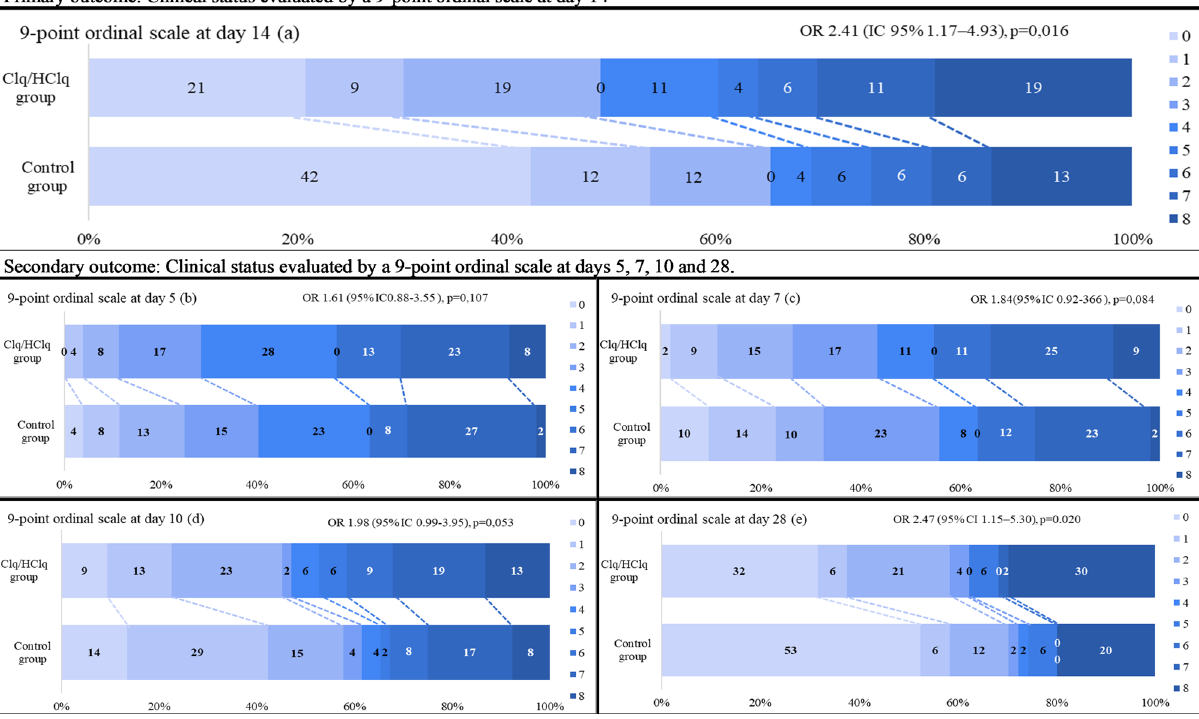
Figure 2. Primary and secondary outcomes in the mITT population from presentation to the evaluation of clinical status with a 9-point ordinal scale. (a) Clinical status evaluated by a 9-point ordinal scale at day 14. (b) Clinical status evaluated by a 9-point ordinal scale at day 5. (c) Clinical status evaluated by a 9-point ordinal scale at day 7. (d) Clinical status evaluated by a 9-point ordinal scale at day 10. (e) Clinical status evaluated by a 9-point ordinal scale at day 28; one patient in the control group did not have an ordinal scale score ascertained at day 28 because of loss to follow-up. The scores on the scale were defined as follows: (0) nonhospitalized and no clinical or virological evidence of infection; (1) nonhospitalized and no limitation on activities; (2) nonhospitalized, but with limitation on activities; (3) hospitalized, but not requiring supplemental oxygen; (4) hospitalized and on oxygen via mask or nasal prongs; (5) hospitalized, on noninvasive ventilation or high-flow oxygen or pressure support ventilation in weaning mode; (6) hospitalized, intubated and on MV; (7) hospitalized on MV and additional organ support (renal replacement therapy, vasoactive drugs or extracorporeal membrane oxygenation), and (8) dead. The percentages shown have been rounded to whole numbers. ORs (95% CIs) and p values were derived from ordinal logistic regression, assuming proportional ORs, adjusted for age and baseline severity (according to ventilatory support) for the mITT population. An OR > 1.00 represents a clinical worsening assessed with the ordinal scale in the Clq/HClq group compared with the control